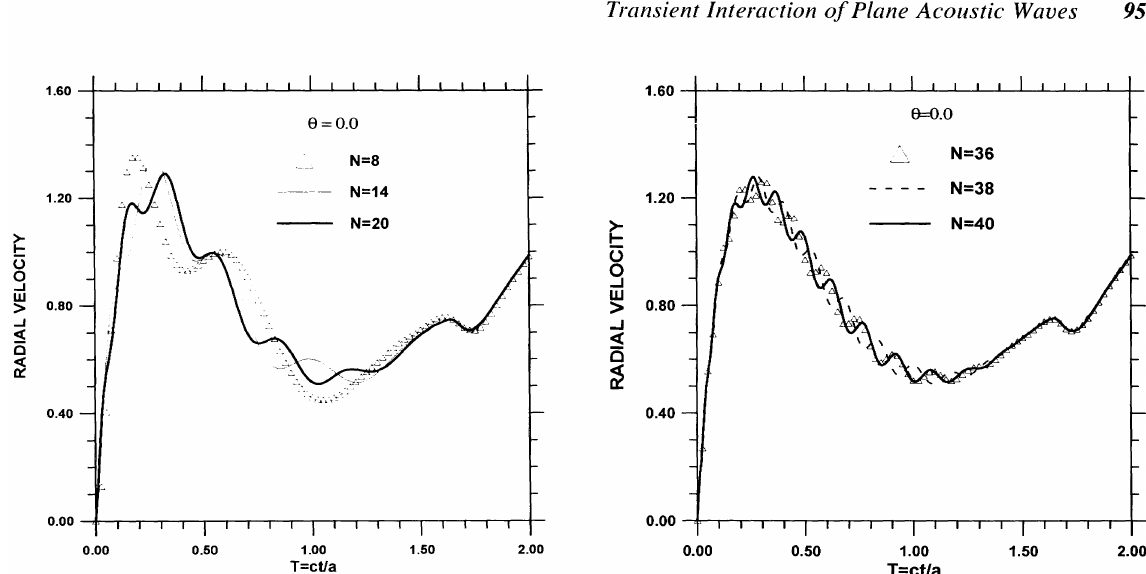
FIGURE 9 Time histories of shell radial velocity due to a step incident wave calculated by the regular sum mations of 9, \5, and 21 terms of the velocity series.